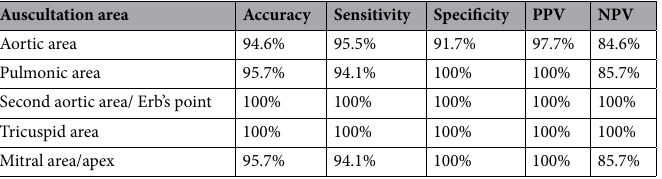
Table 6. Test results of the TAP-CRNN model’s ability to distinguish systolic murmur from normal heart sounds at the 5 standard auscultation